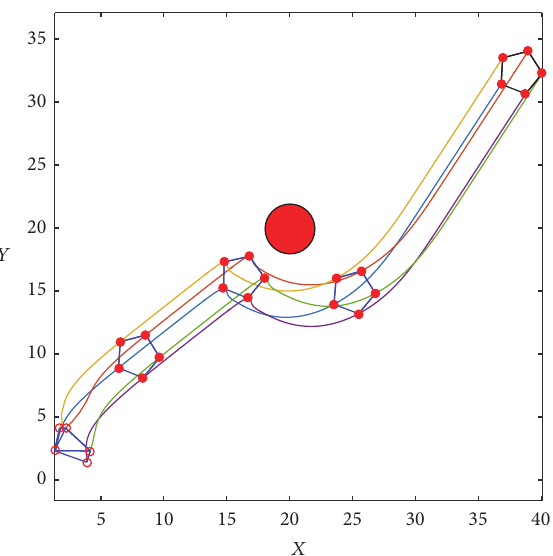
Figure 6: Multiagent robot trajectories with single obstacle.